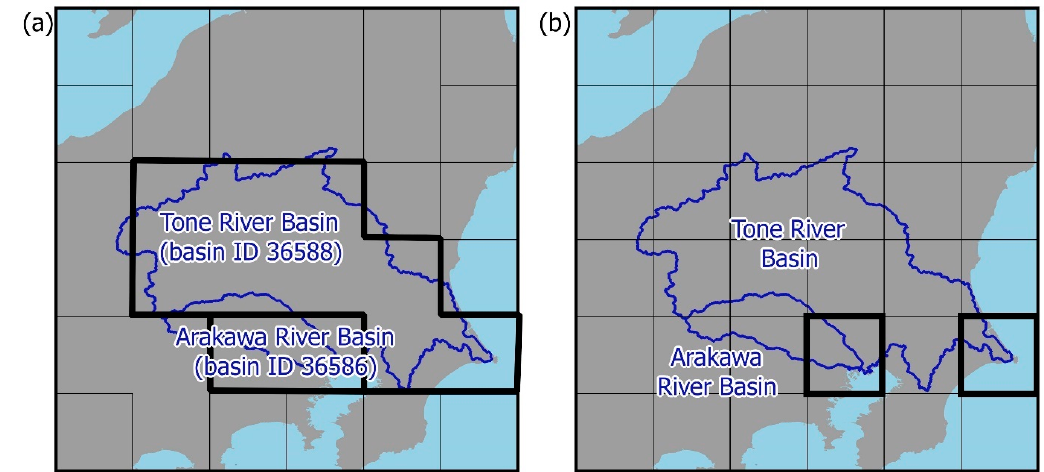
Figure 2. Location of the Tone and Arakawa River Basins in the global datasets of the selected characterization factors. ( a ) Basin ID of the global estimates of WSI (Water Stress Index) and CF AWARE ; ( b ) Grid of the fwua dataset in which the river mouths are located.